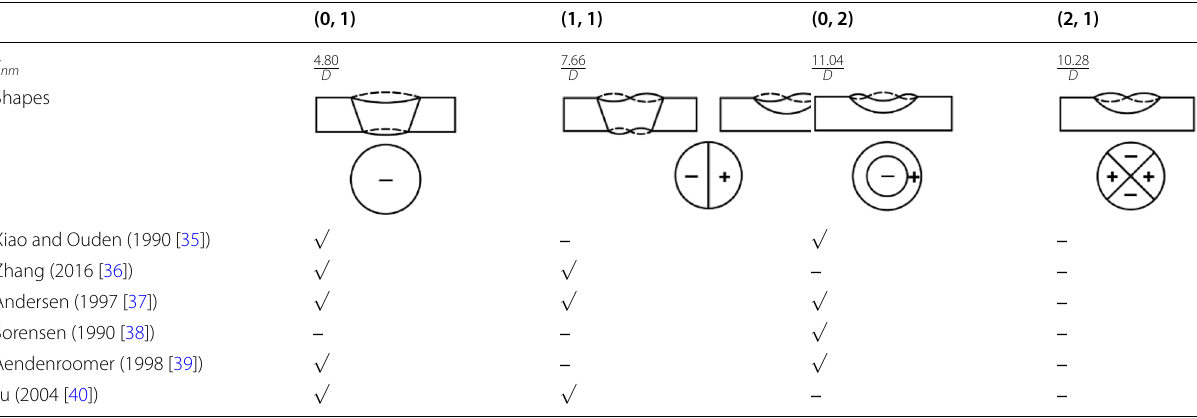
Table 4 Mode shapes of weld pool obtained by different